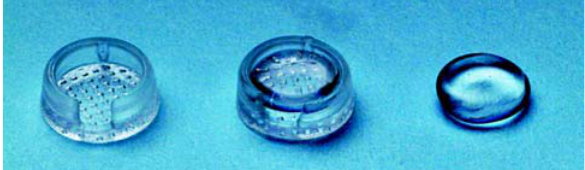
FIGURE 4- The latest version of the fluoride glass slow- release device and plastic retention bracket